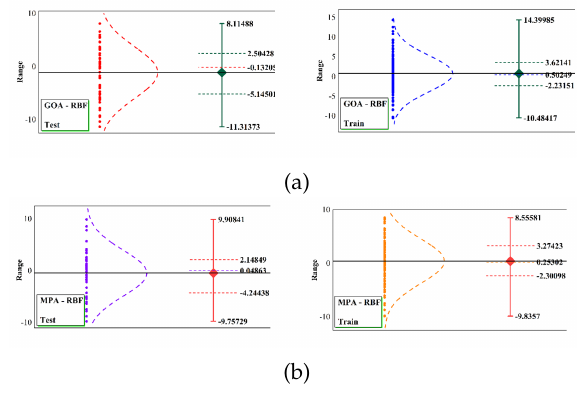
Fig. 9. Box plot of error percentage for proposed